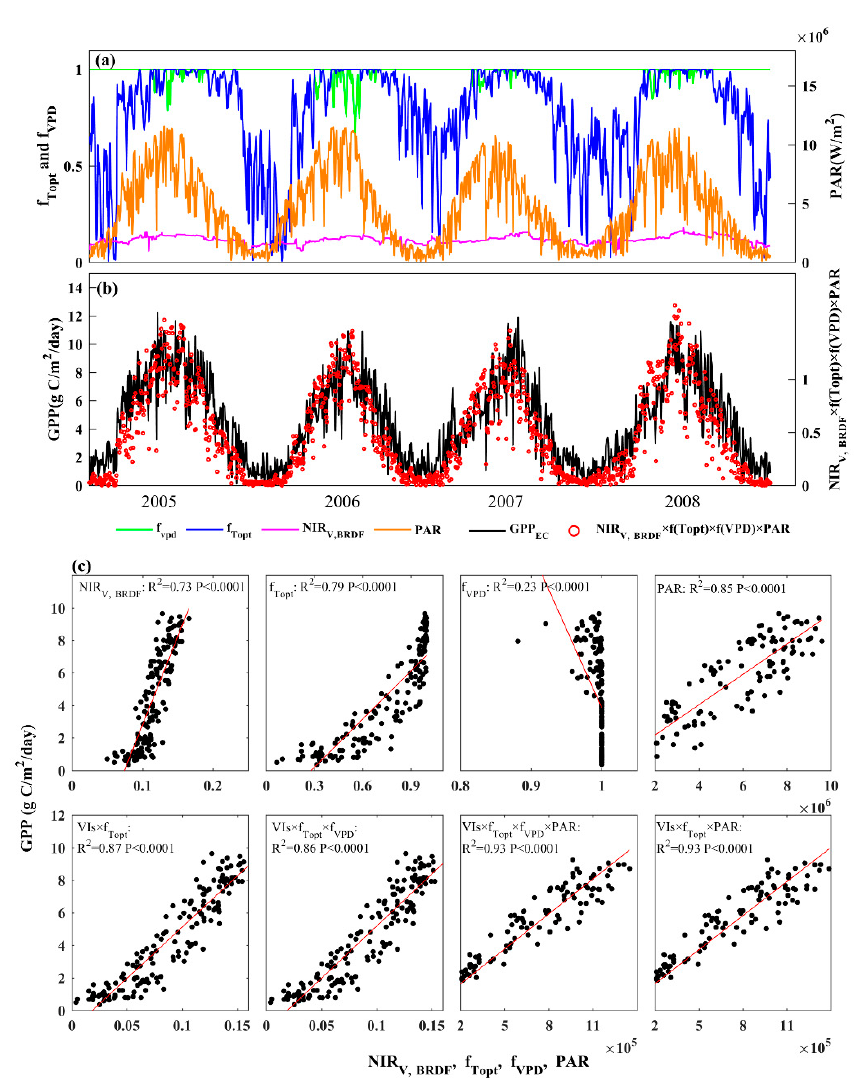
Figure 11. The seasonal cycles and relationship of tower GPP, two environmental scalars (f Topt and f VPD ), and PAR at the Loobos forest site (NL-Loo, the Netherlands) from 2005 to 2008: ( a ) environmental scalars (f Topt and f VPD ) and PAR; ( b ) NIR V, BRDF × f Topt × f VPD × PAR and tower GPP; ( c ) relationships of tower GPP with NIR V, BRDF , f Topt , f VPD , and PAR as well as NIR V, BRDF combined with environmental factors.